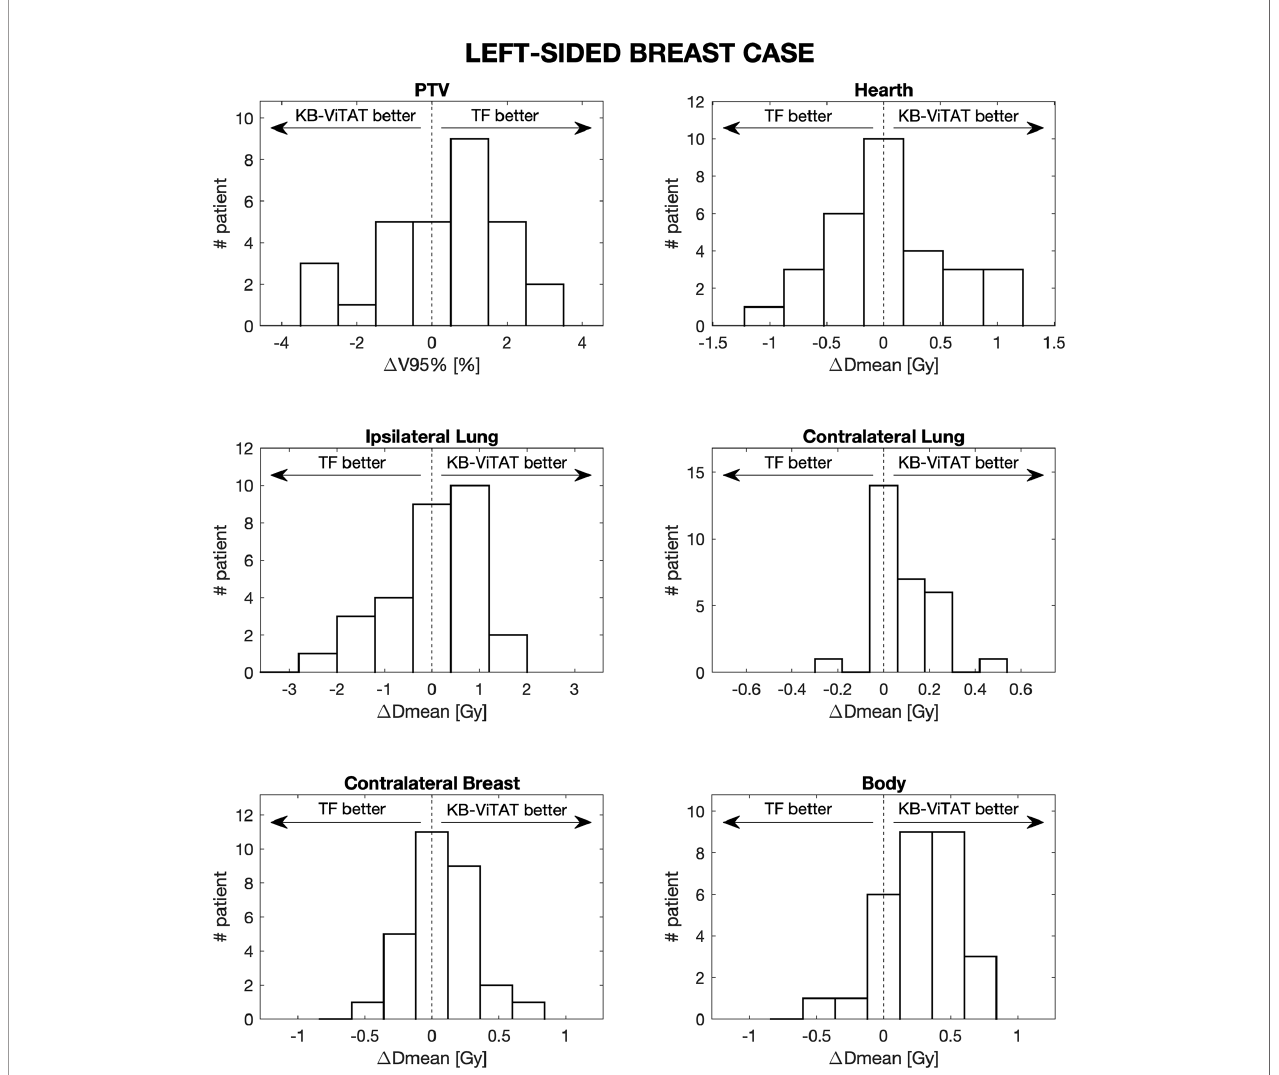
FIGURE 5 | Population histograms of the differences between the clinical tangential fi eld TF and automated re-optimized KB-ViTAT plans for the investigated dosimetric parameters for left-sided breast case, showing the V95% parameter for PTV and mean doses for